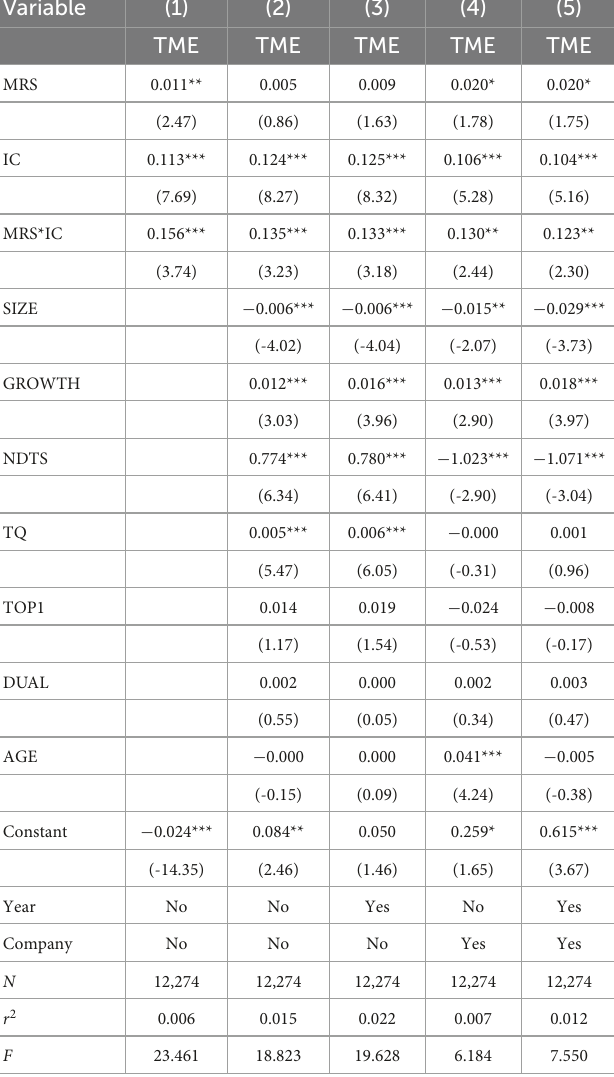
TABLE 5 The effect of internal control on the relationship between executive equity incentive and corporate tax avoidance. Variable